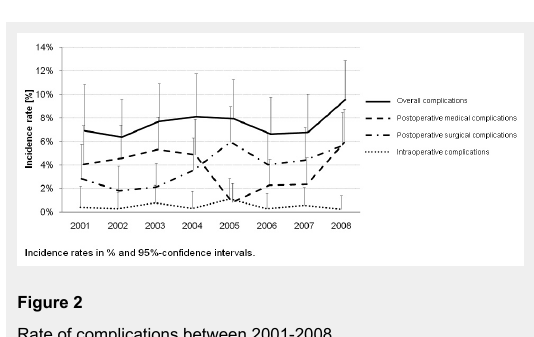
Rate of complications between